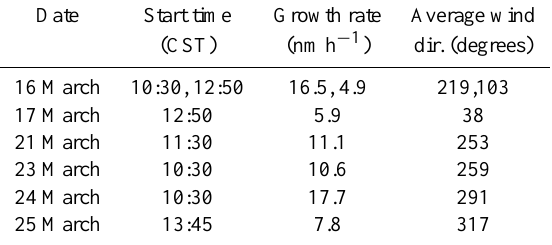
Table 3. Summary of new particle formation events during the MILAGRO field campaign. The average wind dir represents the wind direction averaged over the 10min preceding the event and the 10min after the onset of the